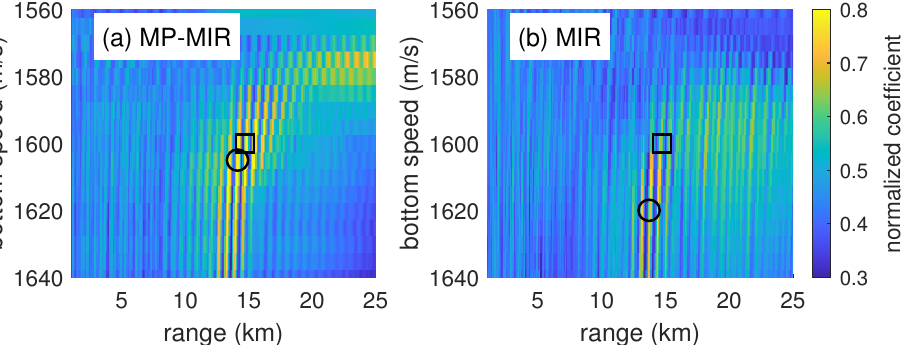
Figure 3. Ambiguous surfaces of MP-MIR ( M r = 3,4) and MIR for the “measured” signal at source depth 10 m. Circles indicate the maximum on ambiguous surfaces, squares indicate the real source– receiver range and the bottom sound speed of the “measured”